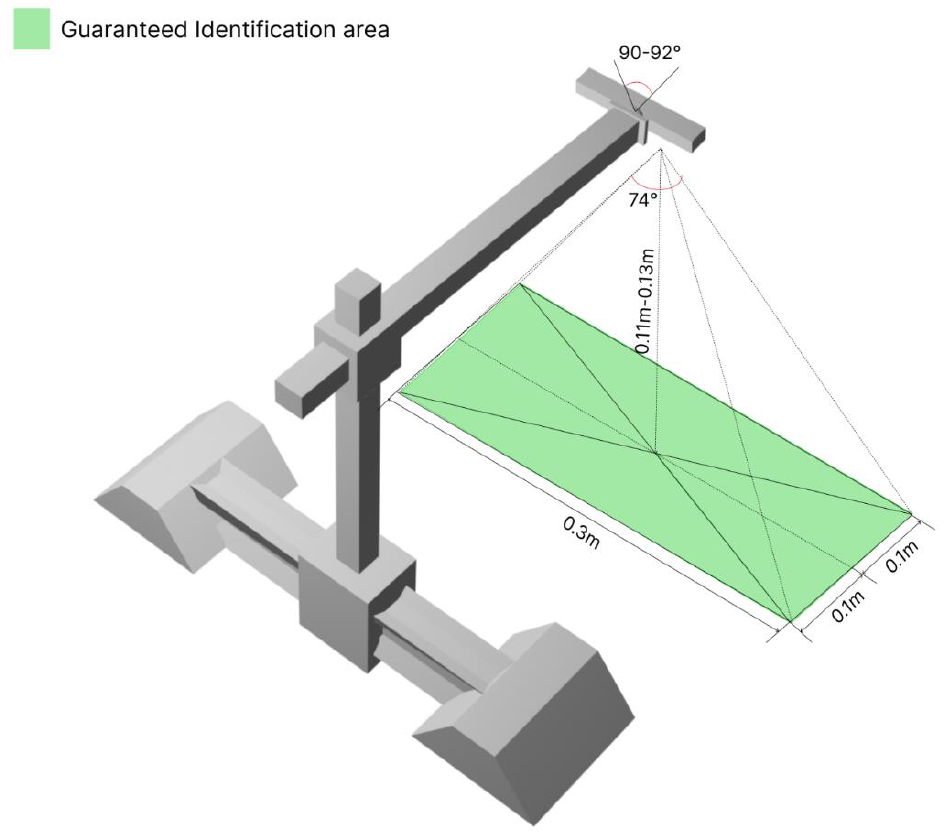
Figure 3. Parameters of a guaranteed identification area above the steel pipe surface.